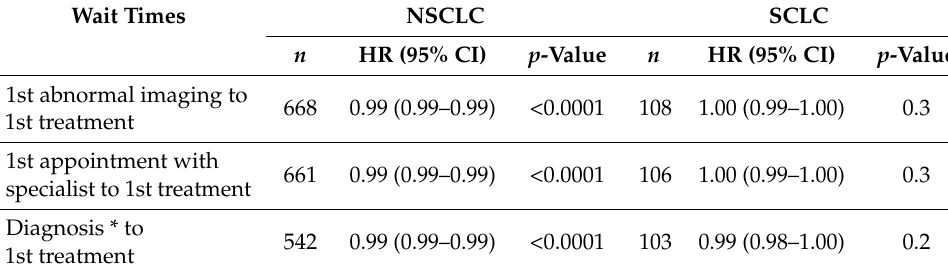
Table A4. Wait times and overall survival, NSCLC versus